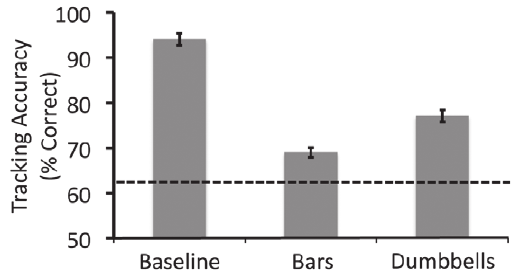
Figure 6. Results from Experiment 4.